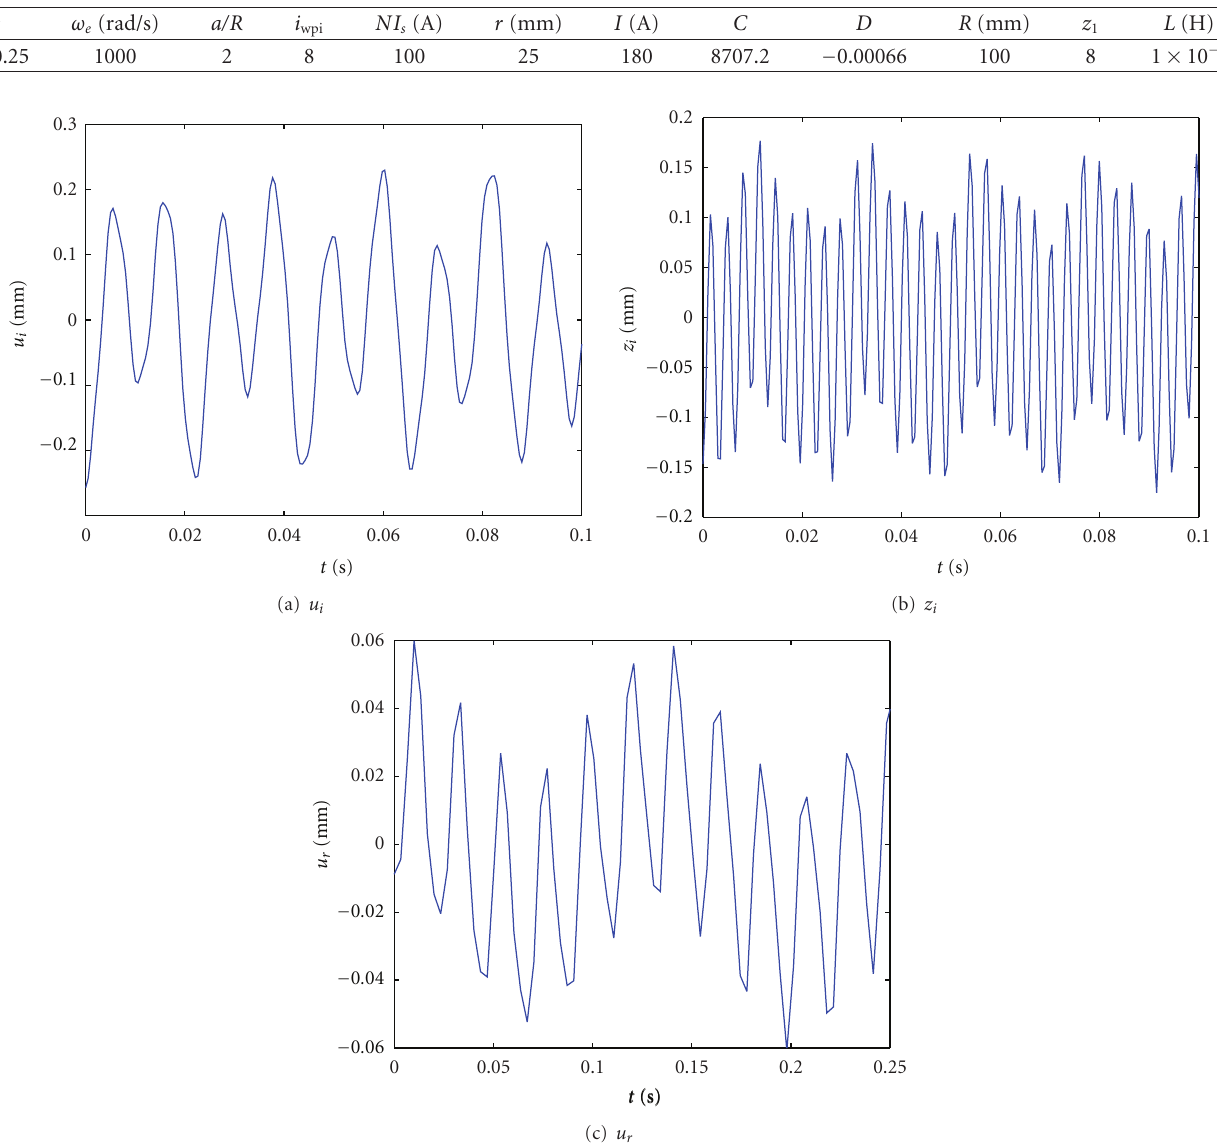
Figure 4: Nonlinear forced vibration to coupled excitations far from natural